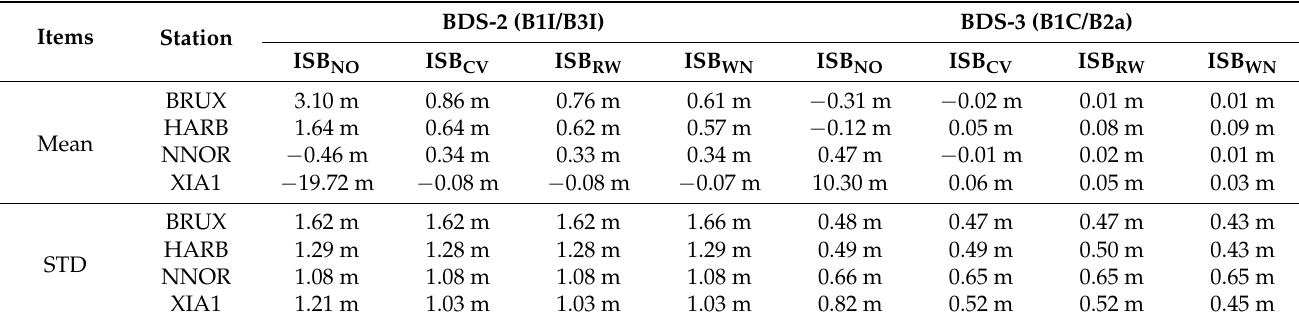
Table 6. The mean and STDs of observation residuals of BDS-2 (B1I/B3I) and BDS-3 (B1C/B2a) satellites for four ISB stochastic models based on GFZ